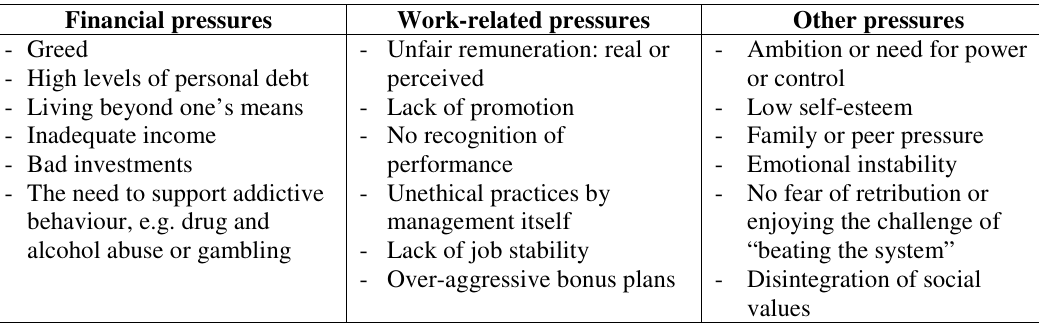
Table 1: Pressures that can lead to fraudulent activities Financial